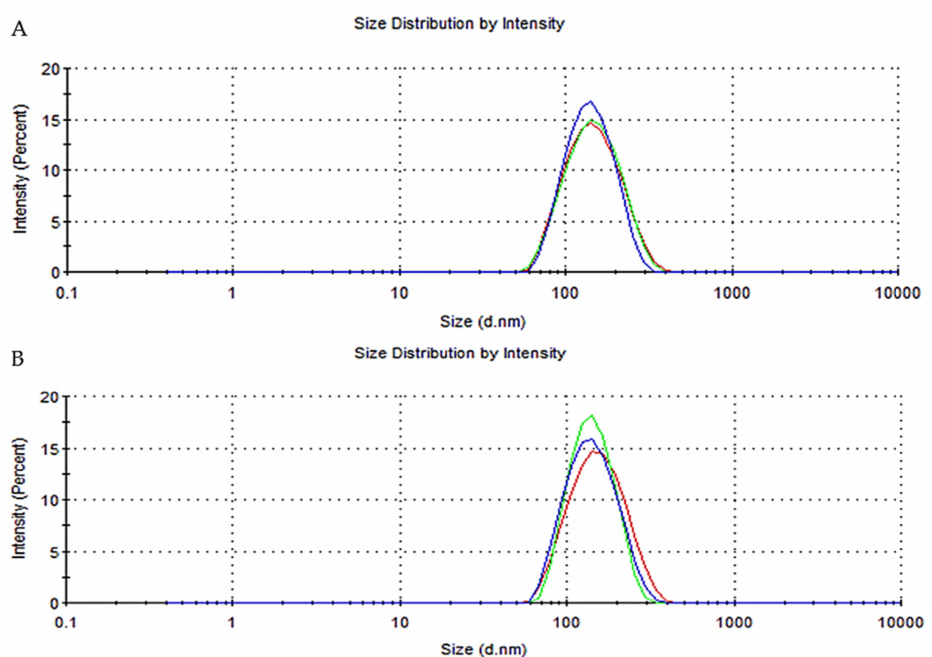
Figure 5. Representative images of the size distribution curves determined by dynamic light scattering (DLS) of the nanocapsules present in the Hydrogel NC SES ( A ) and Hydrogel NC placebo ( B ).